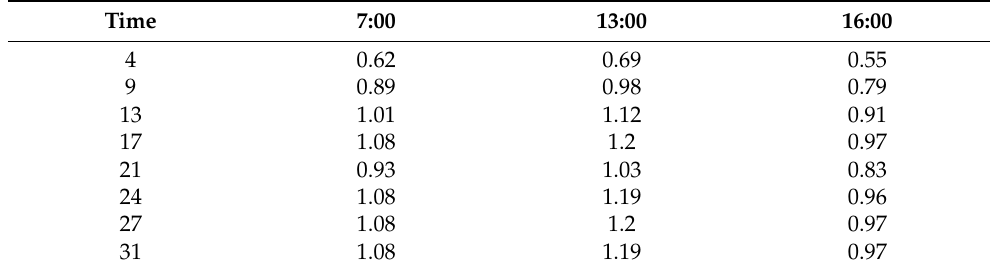
Table A3. The magnitude of the 7th harmonic current of each harmonic source at different times (A).